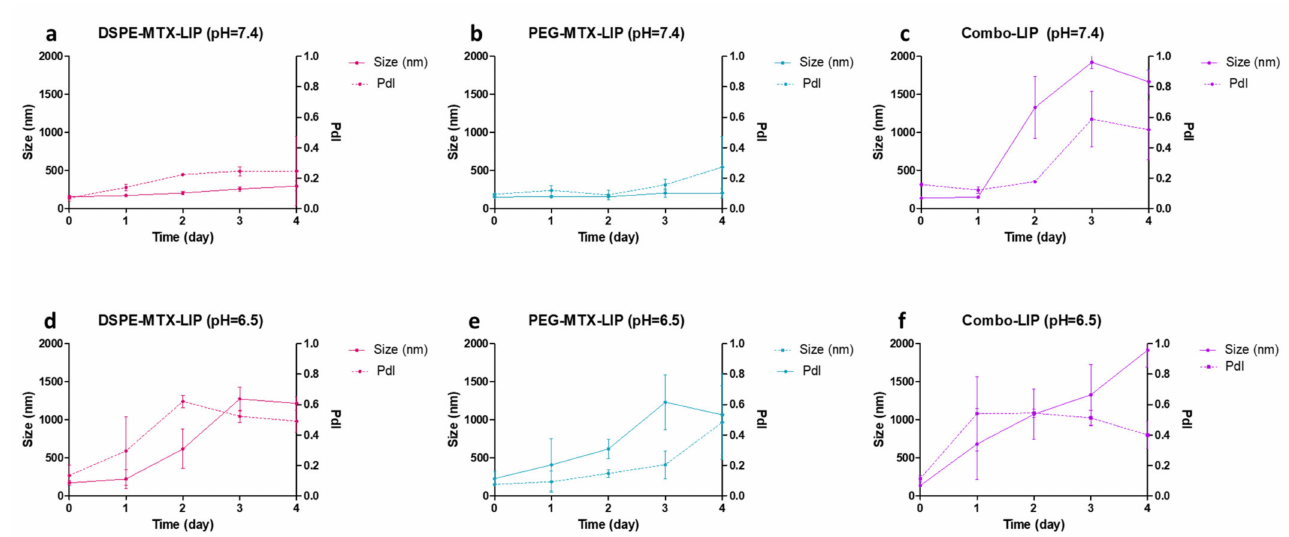
Figure 3. ( a – c ) Stability of all the formulations at pH = 7.4 and ( d – f ) at pH =